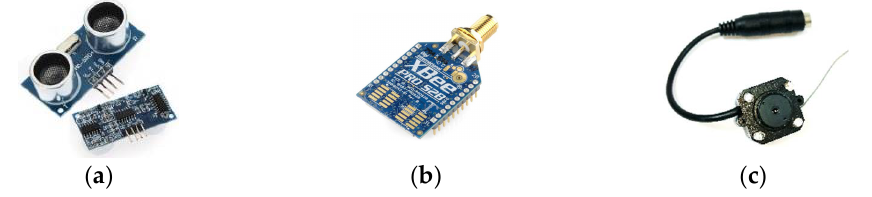
Figure 7. ( a ) Ultrasonic sensor HC-SR04, ( b ) XBee pro s2b, and ( c ) wireless camera.